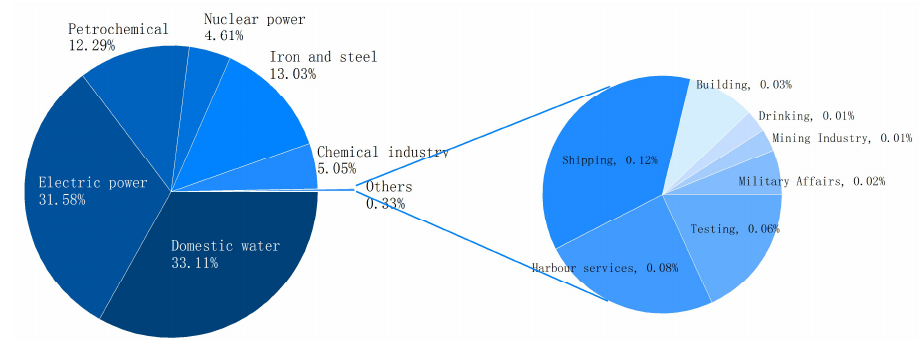
Figure 5. The distribution structure of utilization type of desalinated water in 2017. Data Source: Desalination Branch of China Water Enterprises Confederation, “China Desalination Yearbook 2016–2017” [24].